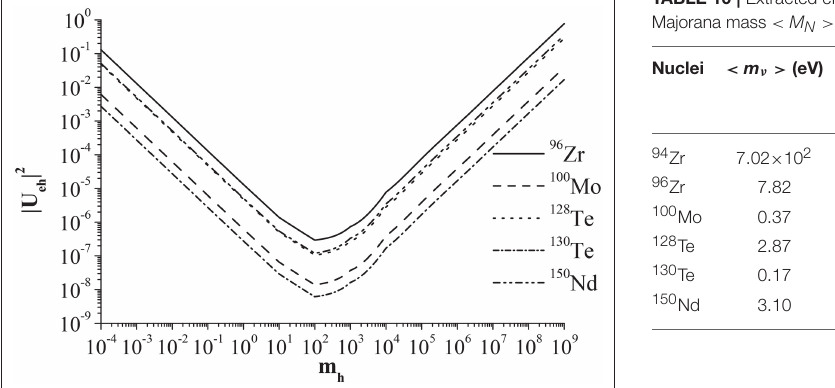
FIGURE 2 | Variation in extracted limits on the ν h 2 with the mass m U eh (cid:12) (cid:12) (cid:12) (cid:12)